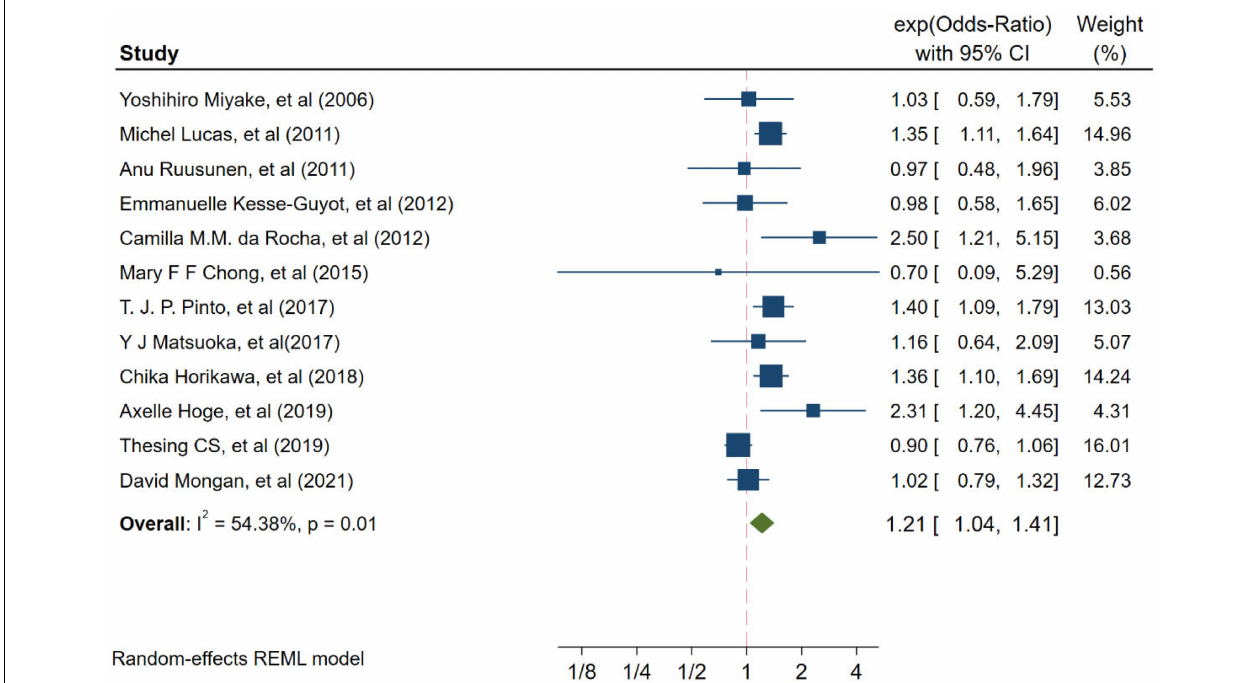
FIGURE 2 | Odds ratios of depression for highest vs. lowest category of ratio of n-6/n-3 PUFAs. Overall odds ratios calculated with random effects model.